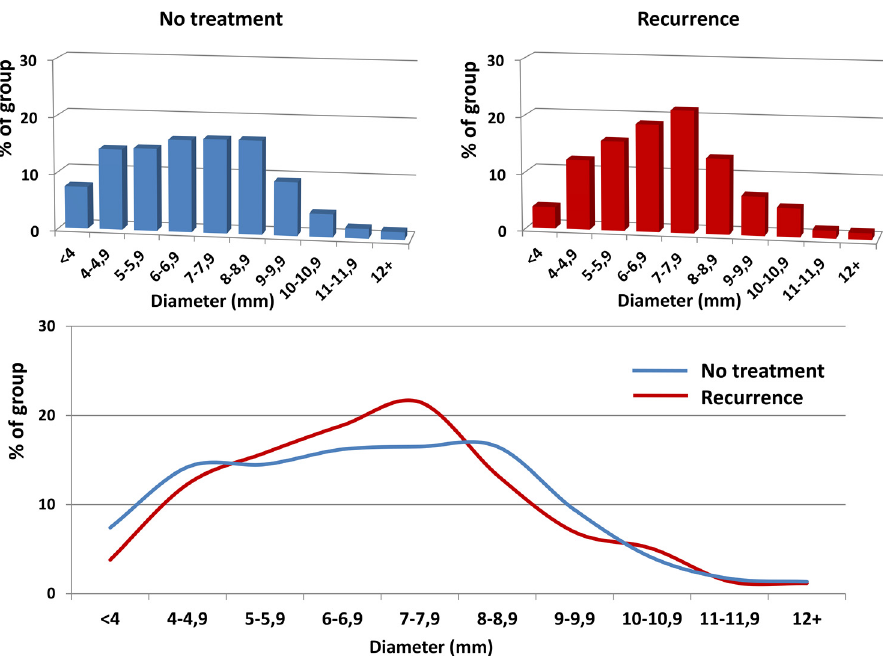
Figure 2. The distribution of left ovarian vein diameters (horizontal axis) in regards to their frequency (vertical axis) in the analyzed groups. The upper graphs show the distribution in each group; the lower graph shows the overlaid data from the upper graphs. Despite a marked shift in the prevalence of the LOV diameters towards patients with a diameter >6 mm in the “Recurrence” group, this difference appeared non-significant (OR 1.22; 95% CI 0.81–1.84; P =